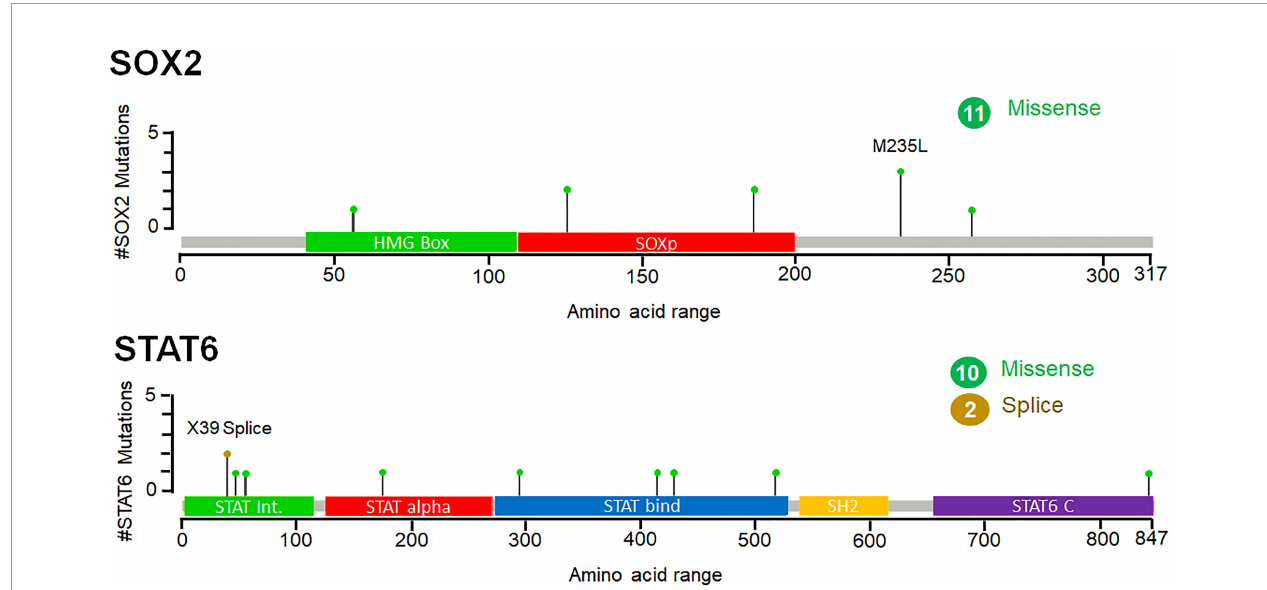
FIGURE 7 | Frequency of point mutations and their types of SOX2 and STAT6 in prostate cancer. The fi gure was generated through the cBioPortal based on the TCGA datasets. Green lollipops represent the missense mutations in SOX2 and